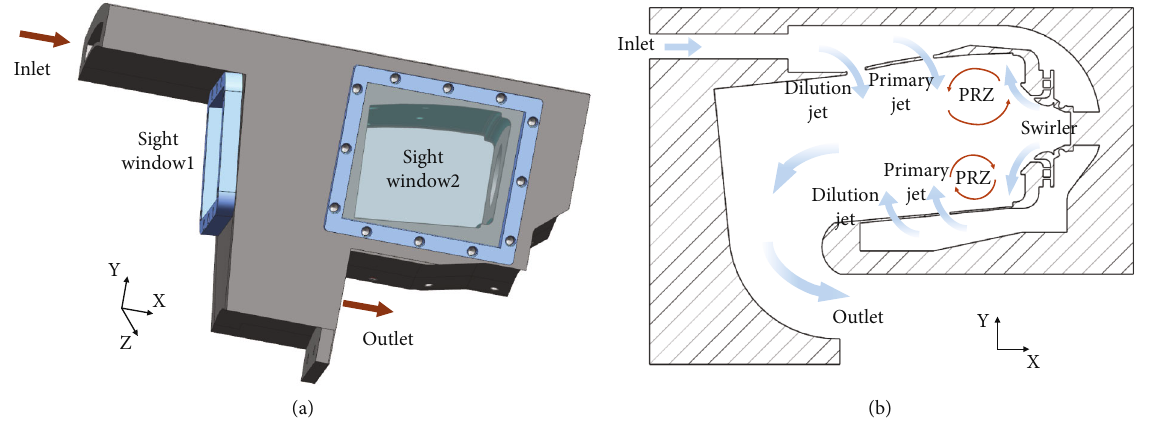
Figure 1: Schematic diagram of the reverse- fl ow combustor. Table 1: Geometrical parameters of the jet holes ( “ Δ ” refers to a round hole, “ Λ ” refers to semicircle hole). Primary holes Dilution